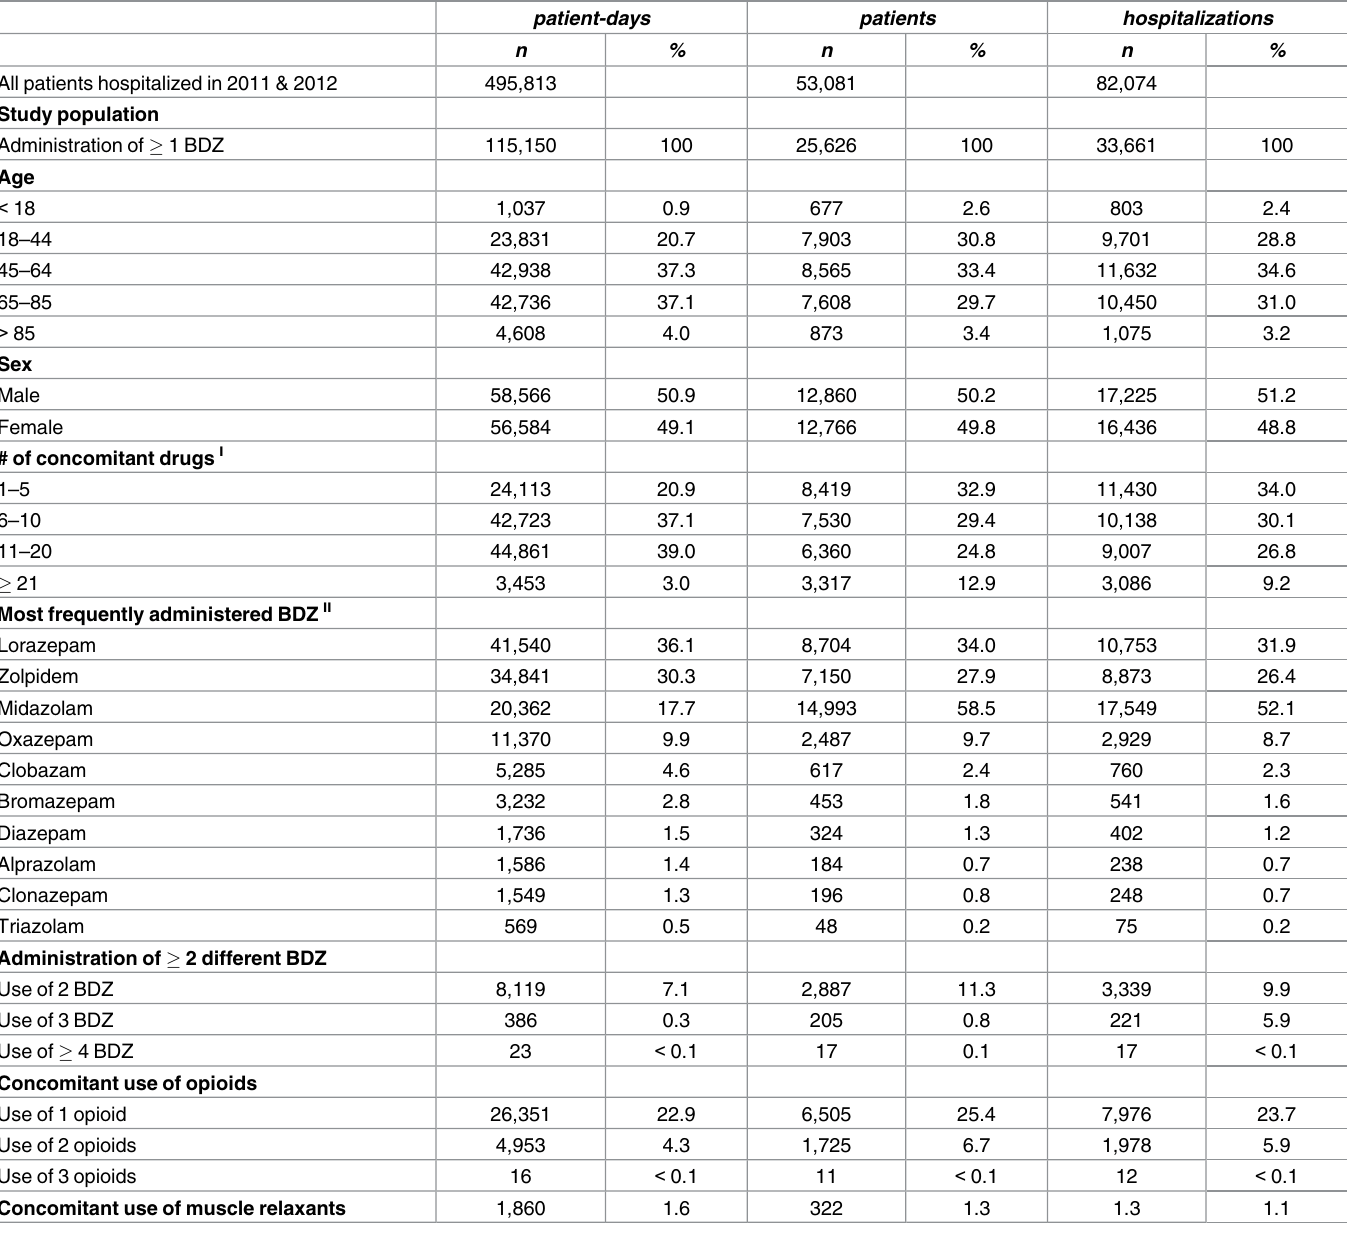
Table 2. Characteristics of the study